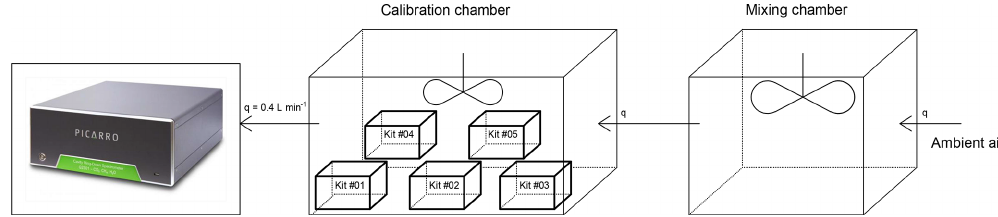
Figure 2. System used at IC3 (Barcelona, Spain) and at the CRAM station (Vielha, Spain), for the calibration of CO 2 sensors mounted on the air enquirer kits.